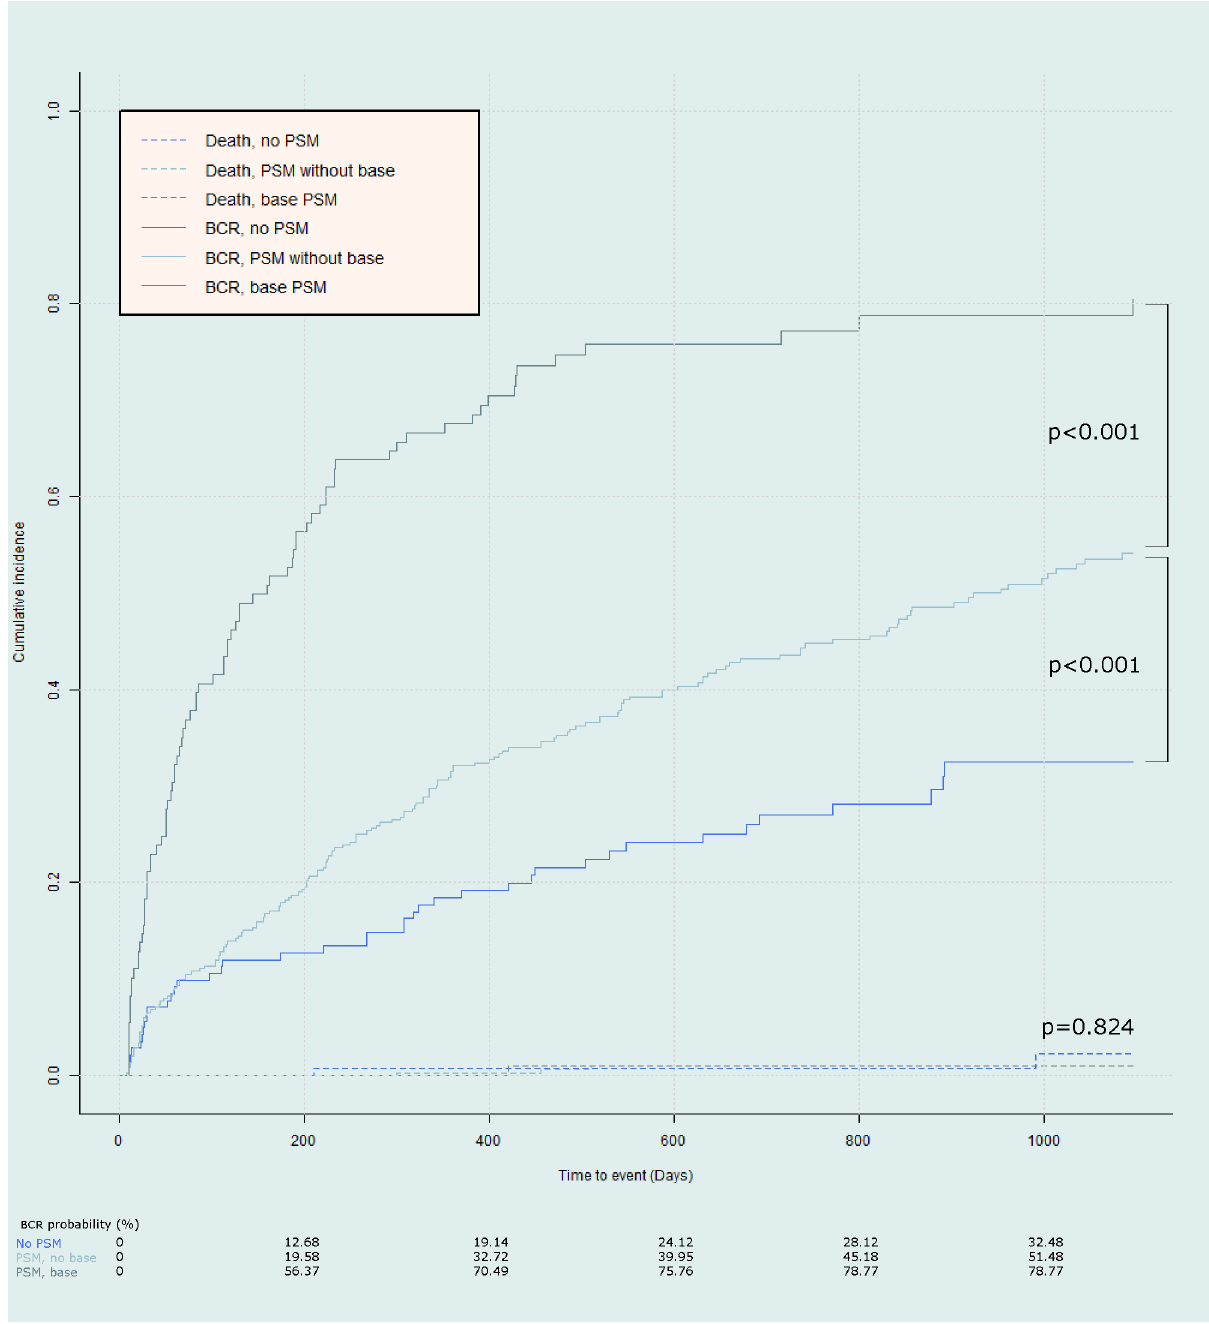
Fig 1. Cumulative incidence curve for BCR stratified according to PSM locations. A markedly increased rate of incidence is noted for the base PSM compared to other PSM locations (p < 0.001, Gray ’ s test for equality). Deaths during follow-up have been plotted as separate dotted lines, which show no differences among groups (p =